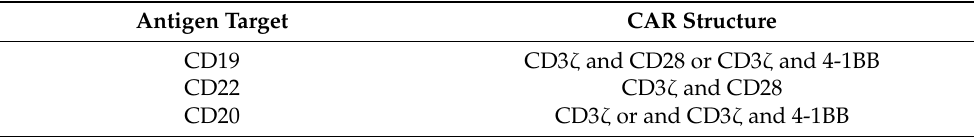
Table 1. CAR T-cell targets for the treatment of B acute lymphoblastic leukemia (ALL).